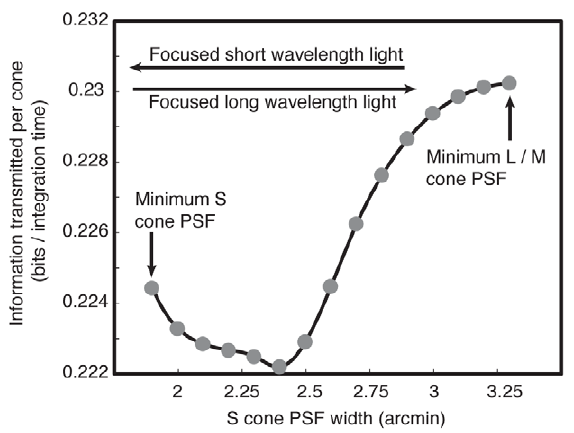
Figure 8. Effects of accommodation on information transmis- sion rate. The information transmitted per cone is highest for an optimal arrangement of L and S cones when light is focused for L cone signals, and consequently more blurred for S cone signals. Results are shown for an array of N=1000 cones; similar curves result for N between 10 3 and 10 6 .